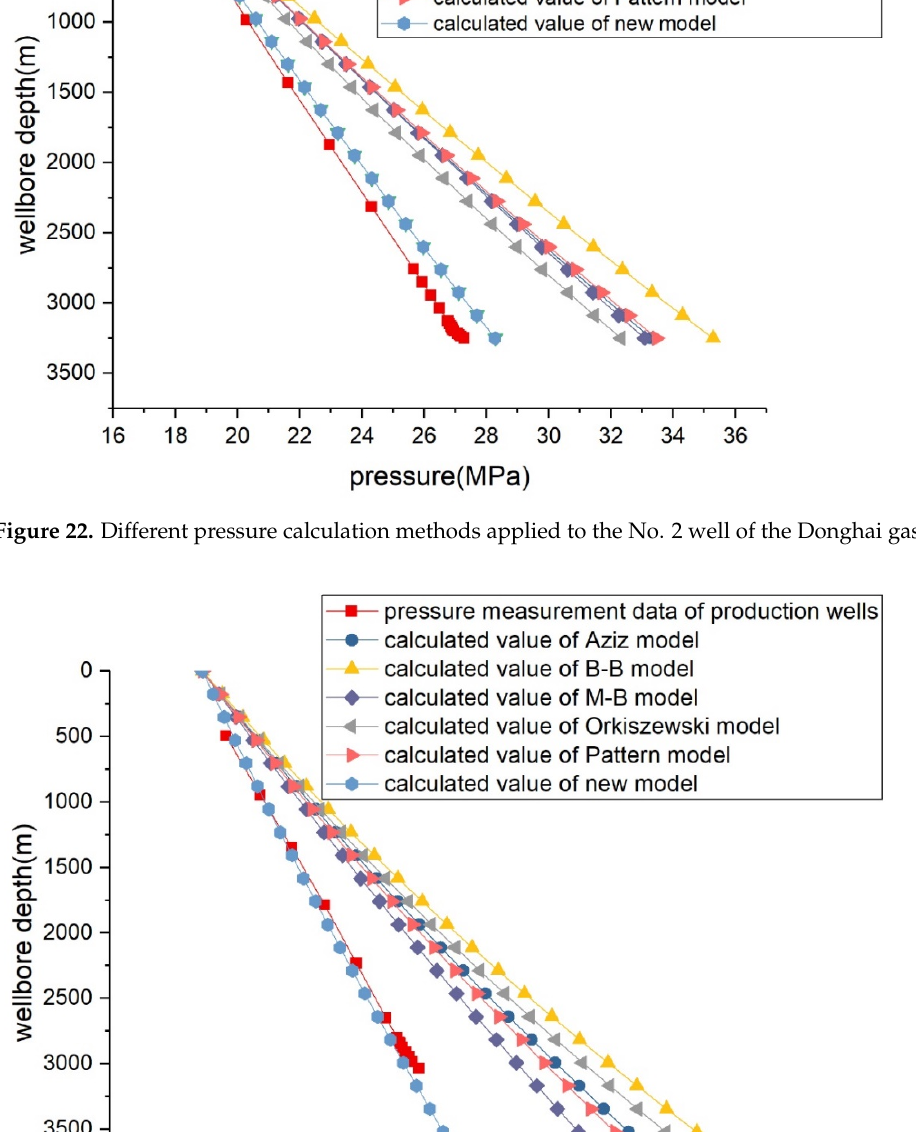
Figure 23. Different pressure calculation methods applied to the No. 2 well of the Donghai gas field.